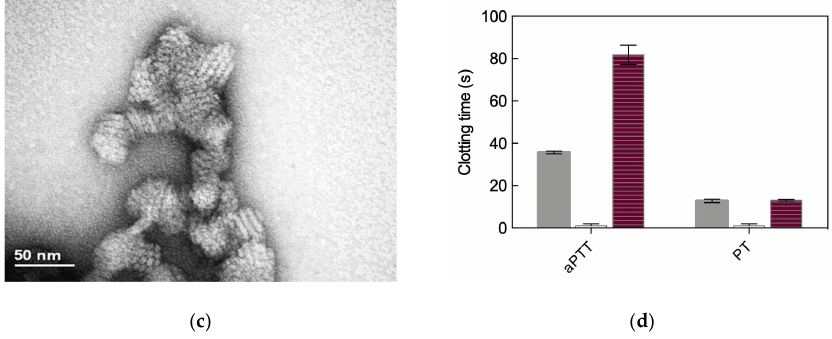
Figure 5. ( a ) Time-decay of the Nile Red normalized fluorescence intensity decay in buffer salted solution (pH = 7.4) in the presence of C 22 G 1 alone (red symbols) and C 22 G 1 and heparin (green symbols). The empty red dot at time = 0 is the light fluorescence observed in the presence of Nile Red alone in solution. TEM images of C 22 G 1 showing the spherical self-assembled nanomicelles in the absence ( b ) and in the presence ( c ) of heparin. ( d ) Clotting times measured in pure plasma (gray bars), in plasma + heparin (white bars), and in the presence of plasma + heparin + C 22 G 1 (gray-striped violet bars) by the aPTT and PT assays. Panels ( a – c ) adapted from [21] and [36], with the permission of The Royal Society of Chemistry.